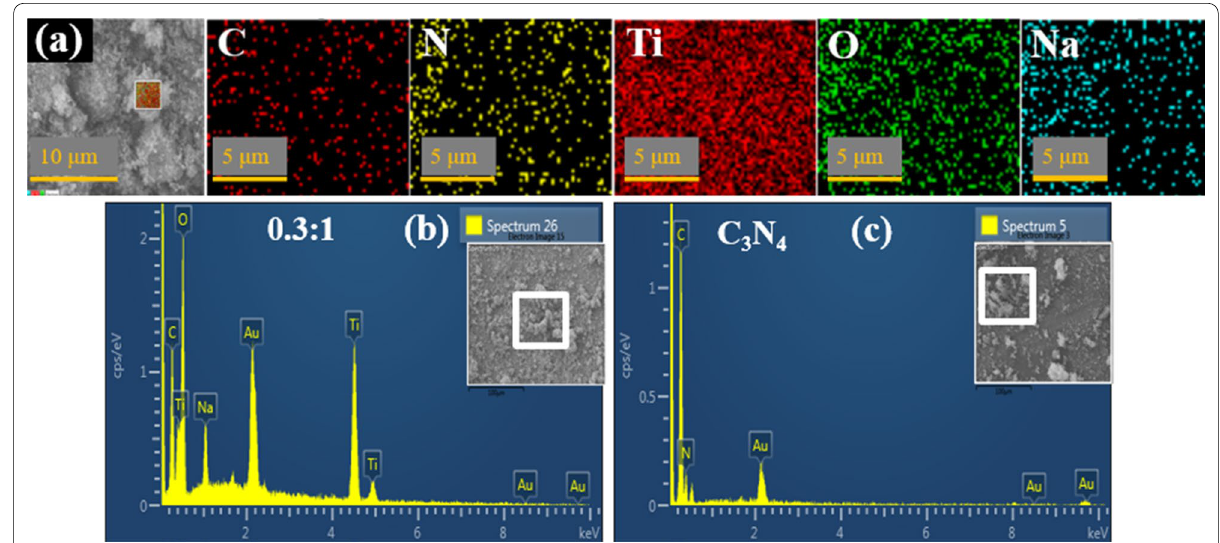
Fig. 4 a Mapping of 0.3:1 sample to ensure distribution of all components ( b – c ) EDX images of 0.3:1 (higher doping) and 1:0,